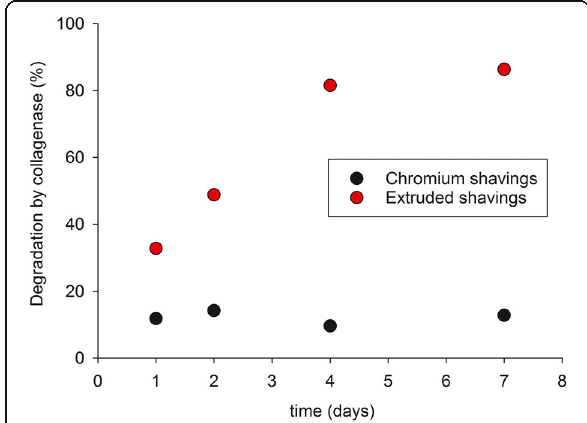
Fig. 3 Degradation degree by collagenase of CS and E100D as a function of